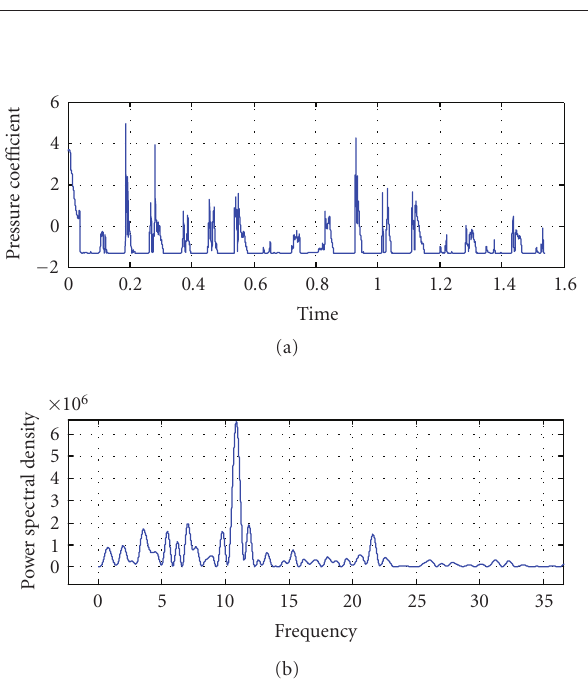
Figure 7: (a) Time evolution of the pressure coe ffi cient at X/c = 0 . 2 and (b) spectral analysis.